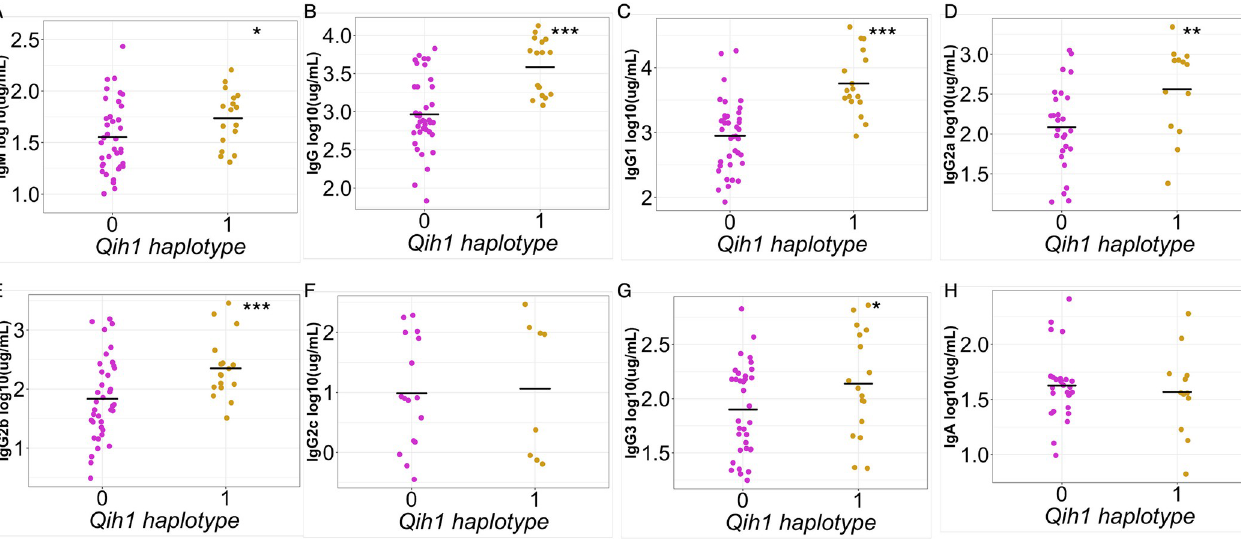
Fig 4. Qih1 shows broad effects across antibody isotypes and subtypes. We assessed the relationship between B6, WSB, and CAST haplotypes ( Qih1 haplotype = 1) and serum concentrations of (A) IgM, (B) total IgG, (C) IgG1, (D) IgG2a, (E) IgG2b, (F) IgG2c, (G) IgG3, and (H) IgA. Each point represents the mean value for each CC strain and the mean for each haplotype group on the x-axis is denoted by the grey crossbar. ( � p < 0.1, �� p < 0.05, ��� p < 0.01) p- values determined using nested linear model approach described in the